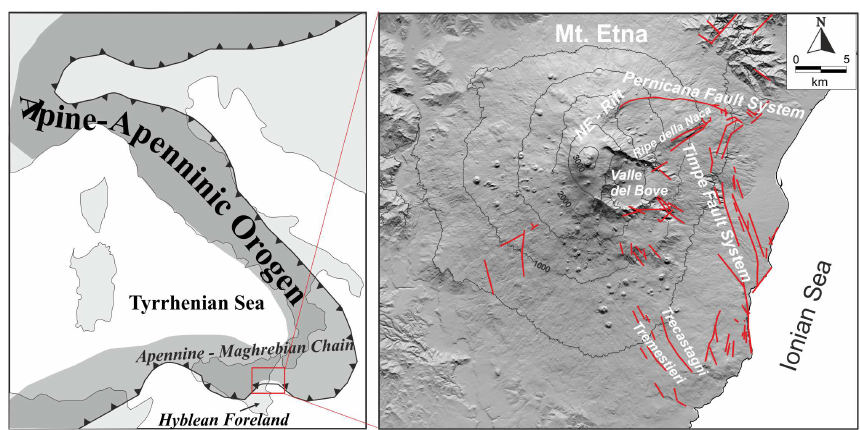
Fig. 3. Maps illustrating the main tectonic and structural features of the studied area (modified from Scarfì et al., 2013).